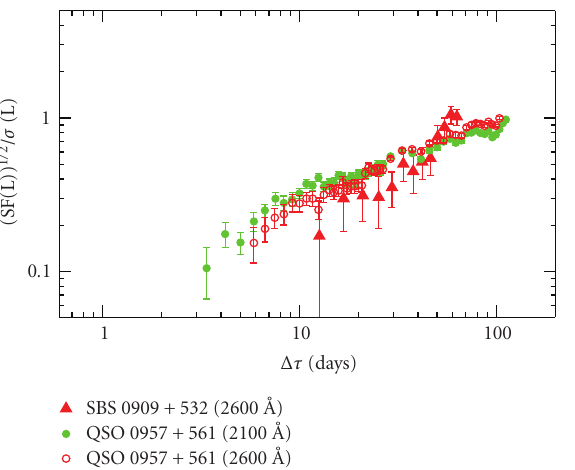
Figure 6: LQLM I structure functions of the UV variability of two lensed QSOs.